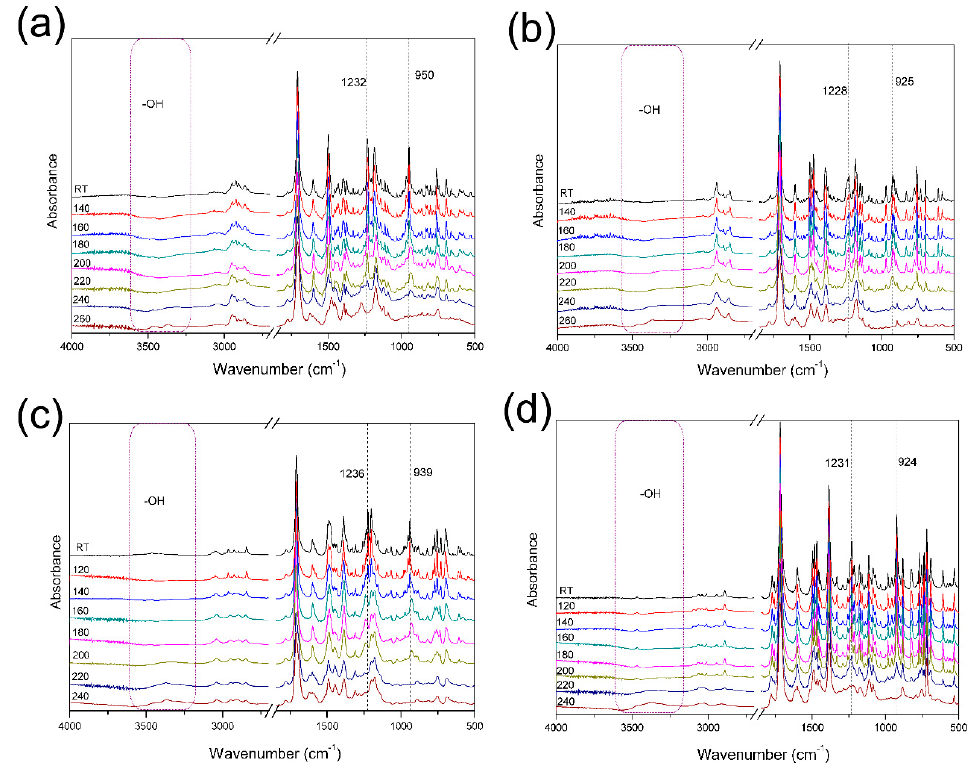
Figure 7. FTIR spectra of the benzoxazine monomers after various thermal treatments: ( a ) o MHI-a, ( b ) o HHI-ac, ( c ) o HTI-a, and ( d ) o PP-a.